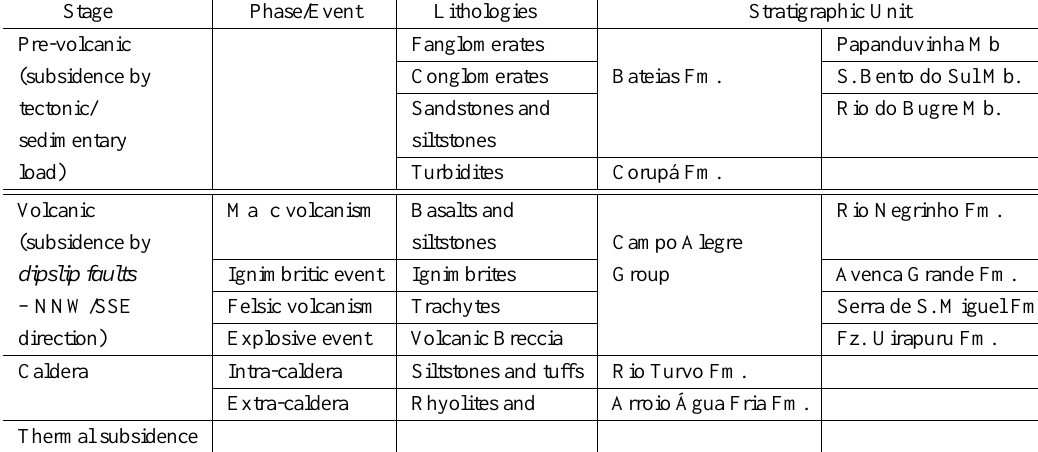
Summary of the relations between the stages and evolution phases of the Campo Alegre Basin and of the lithostratigraphic units proposed in this paper. See also Figure